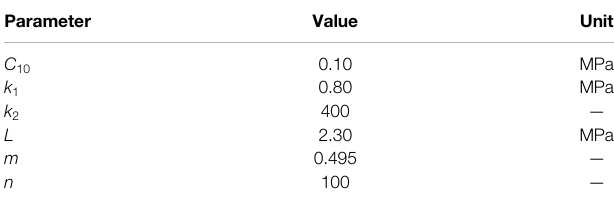
TABLE 2 | Calibrated model parameters for porcine cornea with CXL.